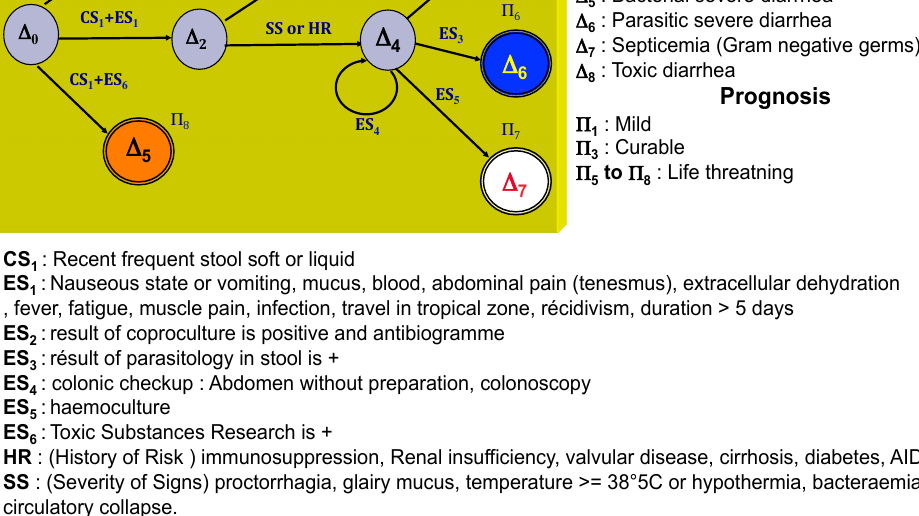
Figure 27. Diarrhea clinical automaton with diagnoses, prognosis and